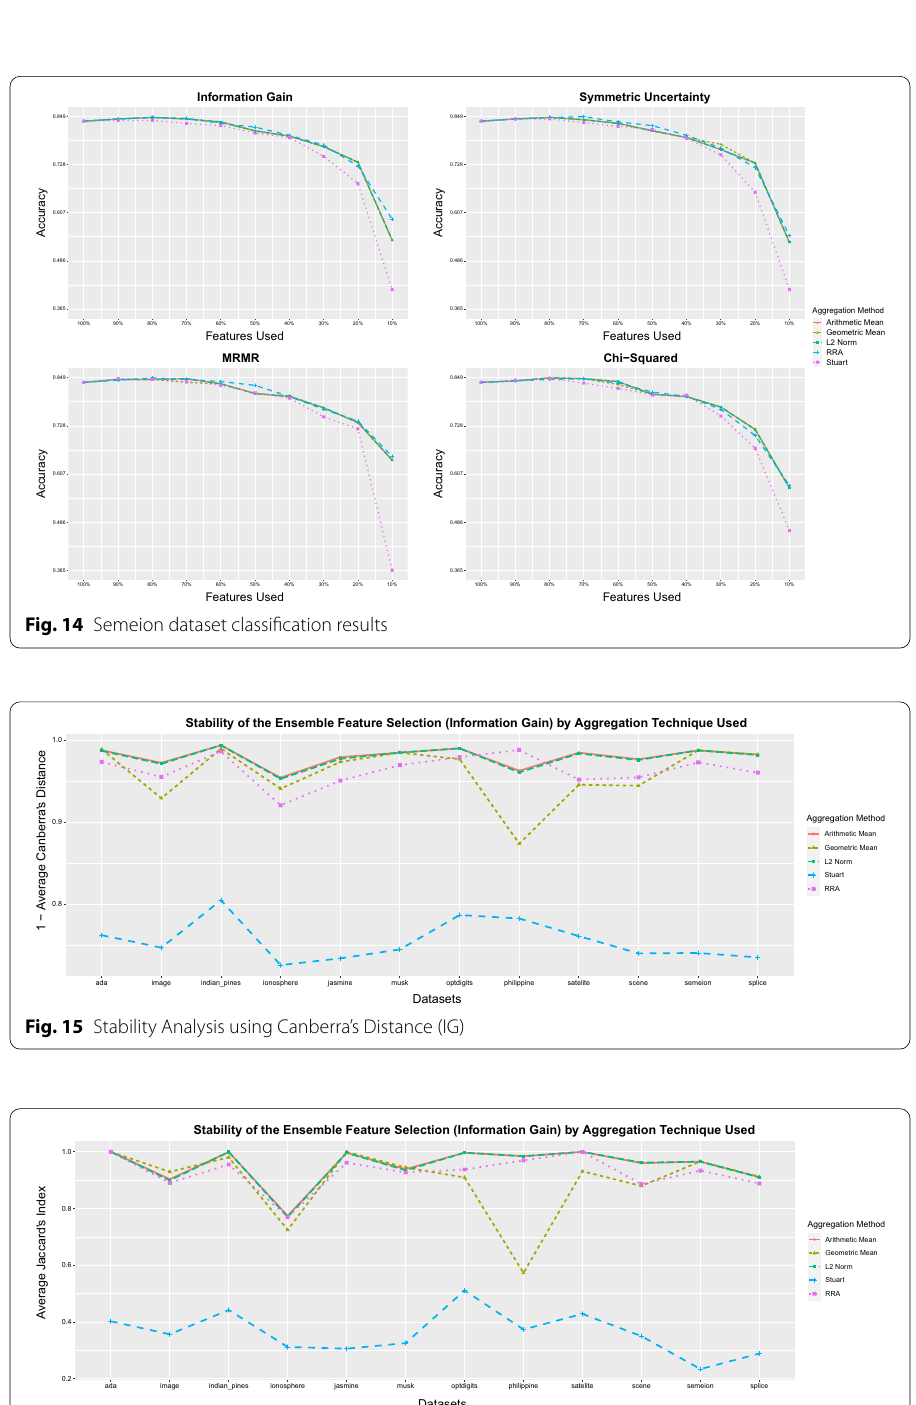
Fig. 16 Stability Analysis using Jaccard’s Index